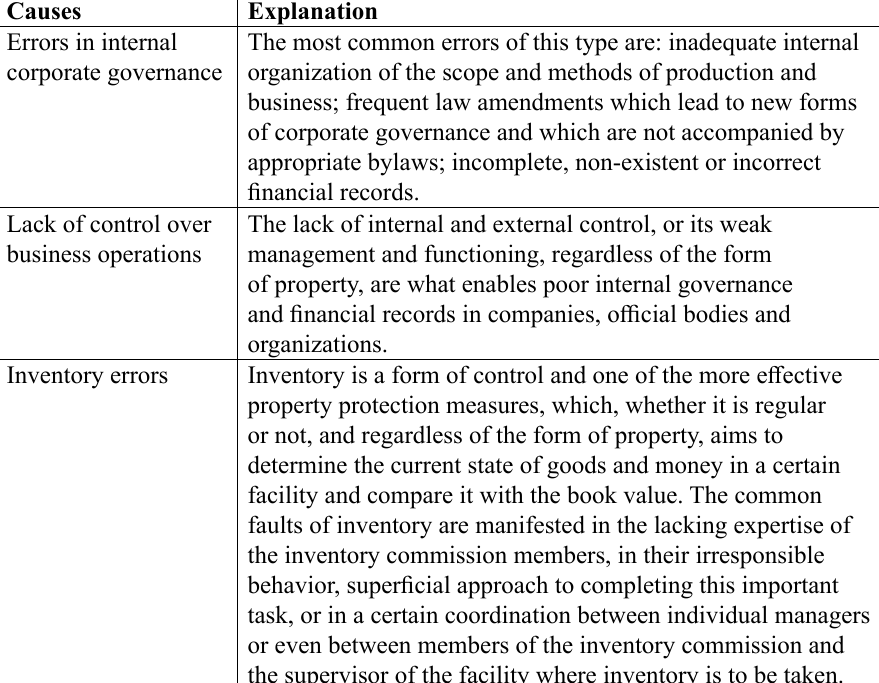
Table 1. General causes of economic crime